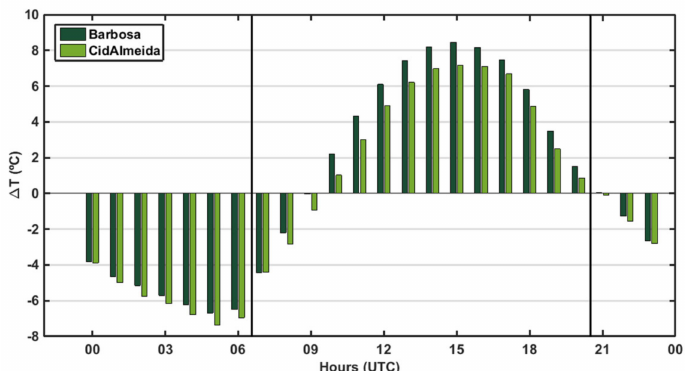
Figure 6. Daily cycle of the temperature difference between air and water at 0.5 m depth in Montante in August 2018. Grey vertical lines indicate the sunrise and